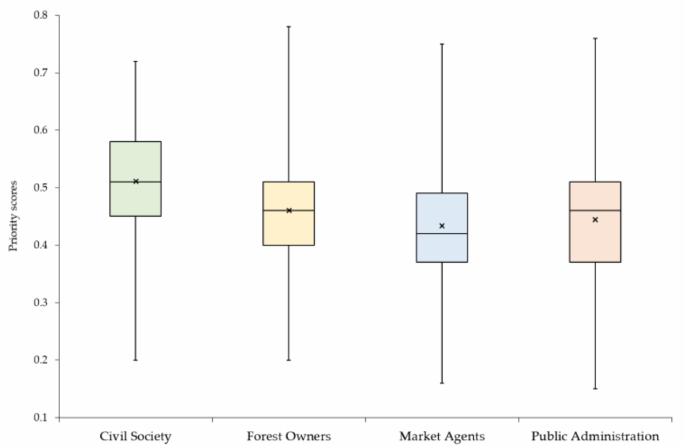
Figure 6. Boxplots of priority scores of the allocation of ecosystem services to management units by interest group. The middle line of the box represents the median between the first quartile (lower end of the box) and the third quartile (upper end of the box). The symbol × represents the mean. The lower and upper bars represent, respectively, the minimum and maximum values of the priority